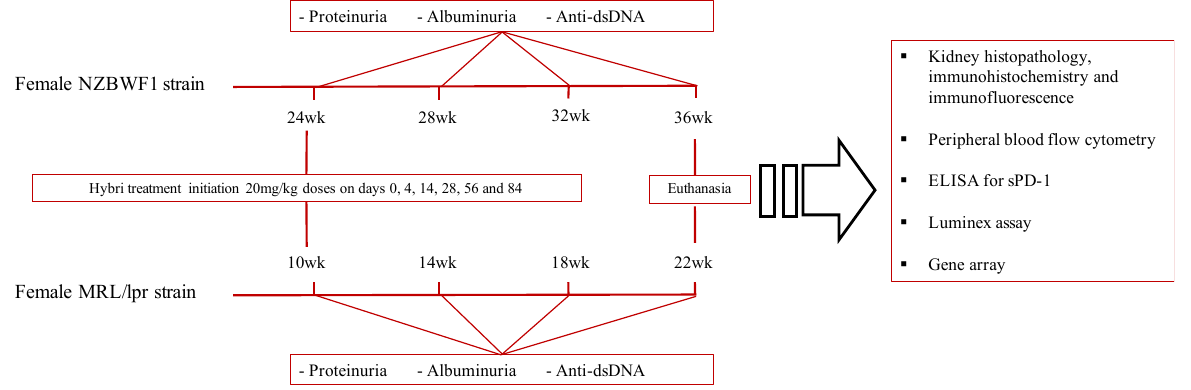
Figure 9. Representative graph of the follow-up of both murine models of lupus nephritis NZBWF1 and MRL/lpr and the analysis techniques performed.